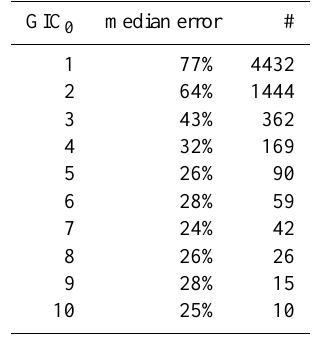
Table 6. As Table 5, but with a conductivity of 0.03993 ohmm − 1 .